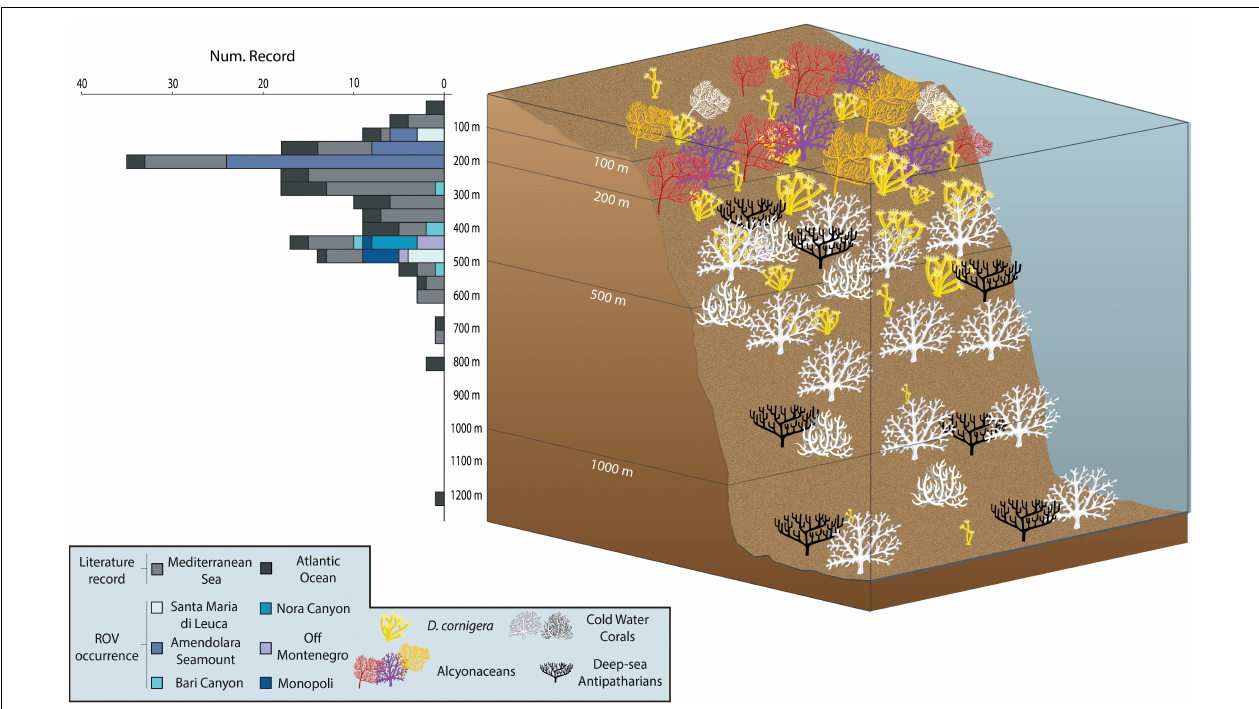
FIGURE 2 | Bathymetric distribution of D. cornigera records. 3D schematic representation showing the bathymetric distribution, and the number of D. cornigera records from literature review and ROV analysis performed in this study, by depth